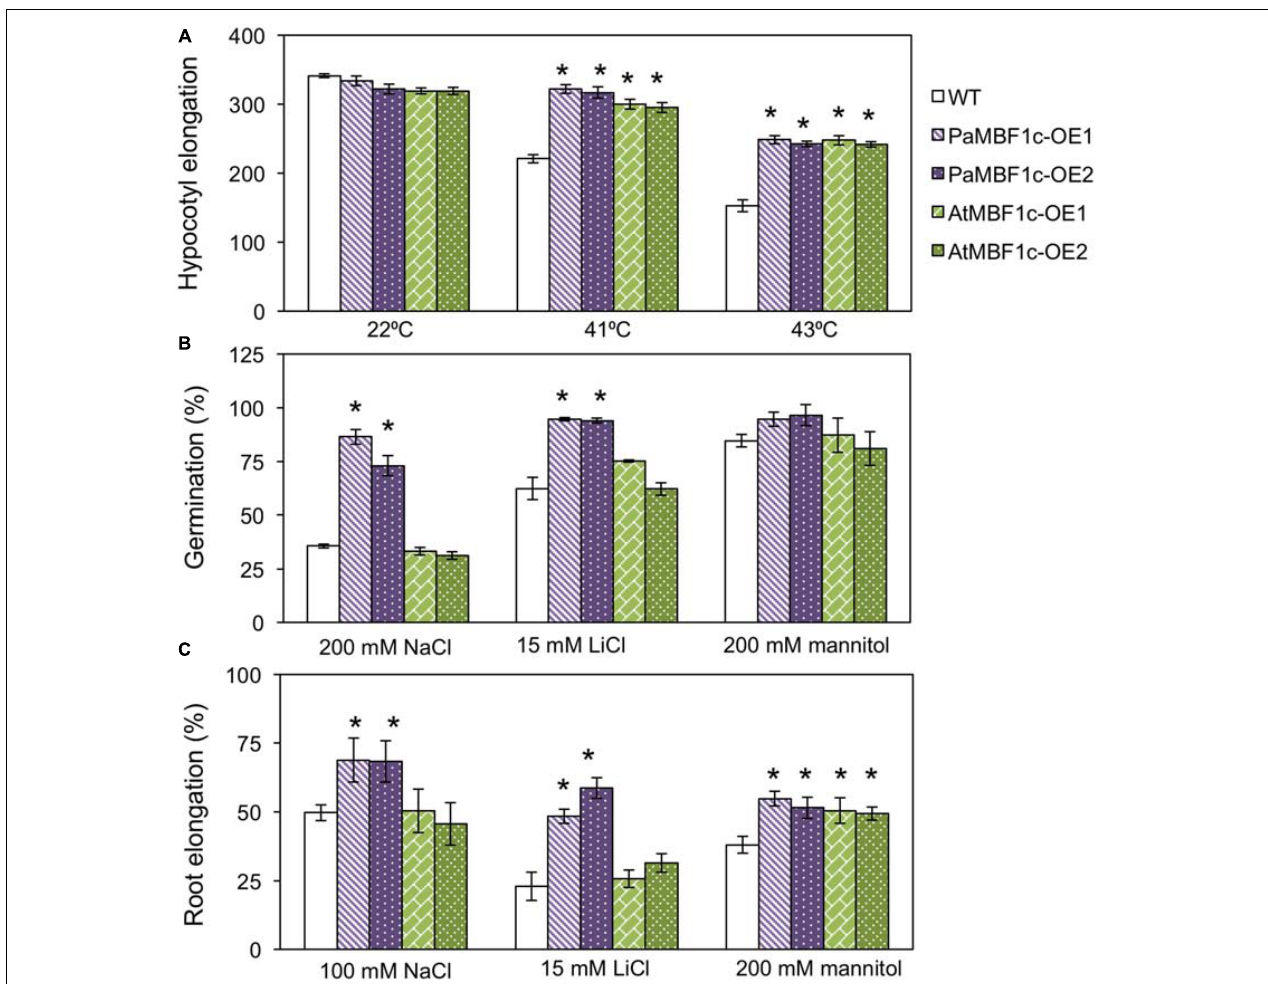
FIGURE 6 | Comparison of stress tolerance between PaMBF1c -OE lines and AtMBF1c -OE lines under various abiotic stress conditions. (A) Comparison of hypocotyl elongation between PaMBF1c -OE and AtMBF1c -OE lines under heat stress. Both OE lines showed similar levels of heat tolerance but higher than WT ( n ≥ 10). (B) Comparison of germination between PaMBF1c -OE and AtMBF1c -OE lines under salt stress (200 mM NaCl), ionic stress (15 mM LiCl), and osmotic stress (200 mM mannitol). PaMBF1c -OE displayed higher germination ratio than WT and AtMBF1c -OE lines under salt and ionic stresses ( n ≥ 100). (C) Comparison of root elongation between PaMBF1c -OE and AtMBF1c -OE lines under salt stress (100 mM NaCl), ionic stress (15 mM LiCl), and osmotic stress (200 mM mannitol). PaMBF1c -OE showed higher root elongation than AtMBF1c -OE and WT under salt and ionic stresses ( n ≥ 10). Error bars represents standard deviation of the mean values of three independent experiments. Asterisks indicate statistical significance in LSD test ( p <